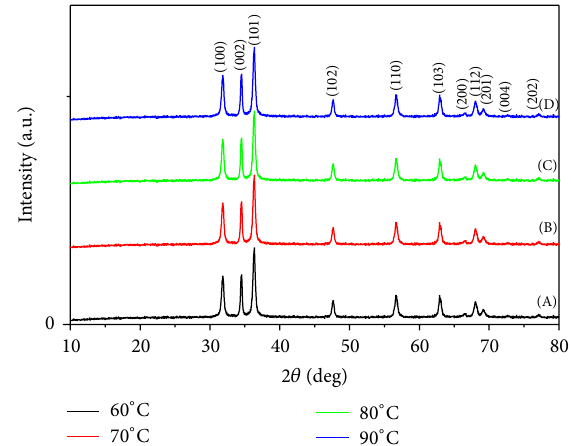
Figure 5: XRD patterns for ZnO nanopowders via sol-gel technique at different reaction temperatures: (A) 60 ∘ C, (B) 70 ∘ C, (C) 80 ∘ C, and (D) 90 ∘